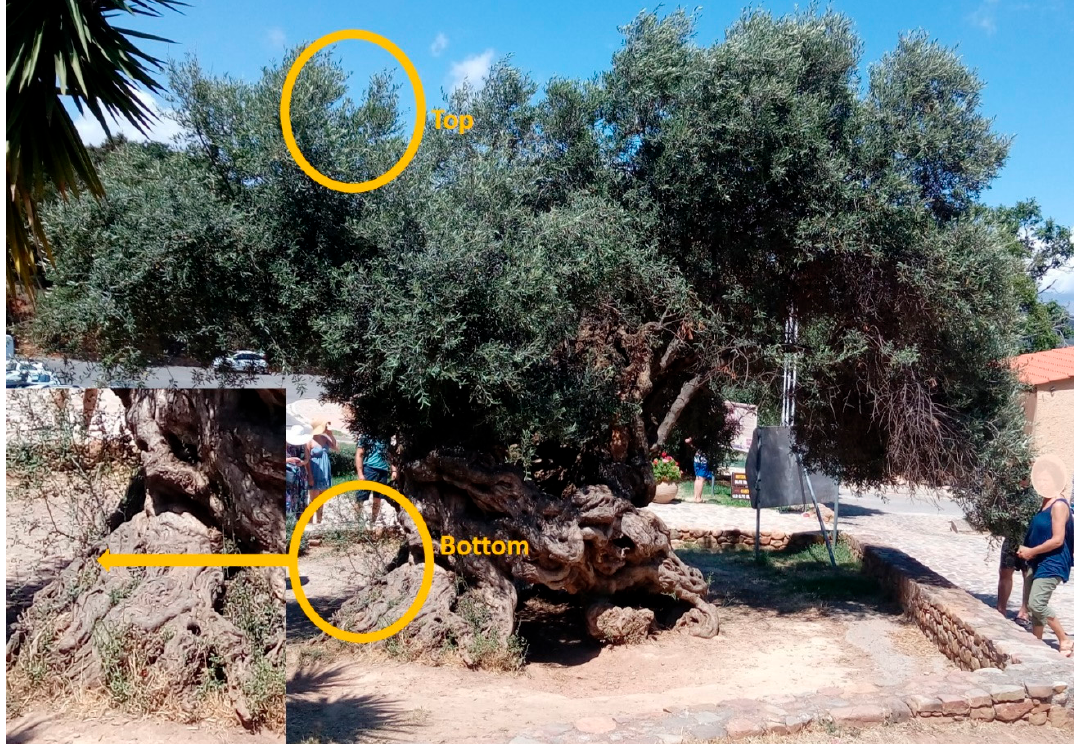
Figure 1. Vouves monumental olive tree picture. The places from which the samples were taken are marked in yellow.